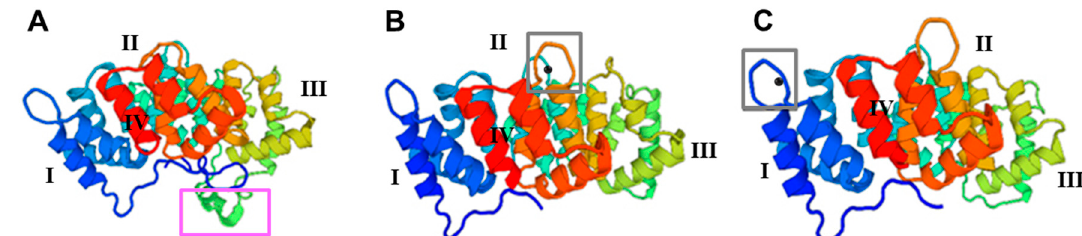
Figure 3. Predicted 3D structural models of: TmAnxB2 ( A ); TmAnxB3 ( B ); and TmAnxB12 ( C ). ( A ) The structure of TmAnxB2 is based on the crystal structure of S. mansoni Annexin (PDB accession